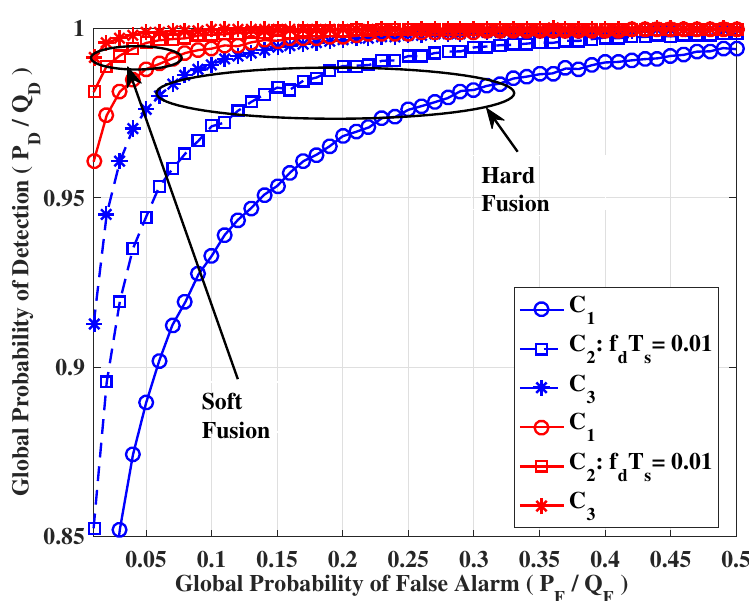
Figure 11. The ROC curves of cooperative sensing ( N = 20, K = 50, η 0 = − 8